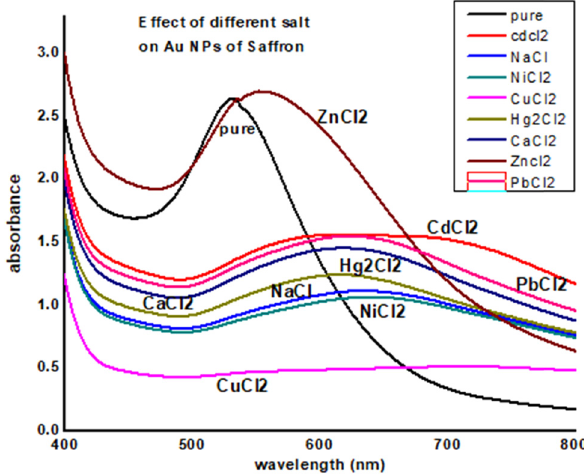
Figure 8: UV - Visible data of e ff ect of di ff erent salts on sa ff ron stigma AuNPs ( SS - AuNPs ) .